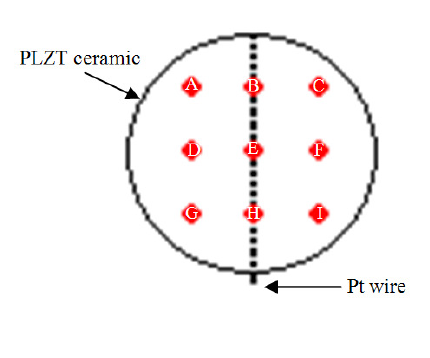
Figure 5. Zones selected for the mechanical analysis.